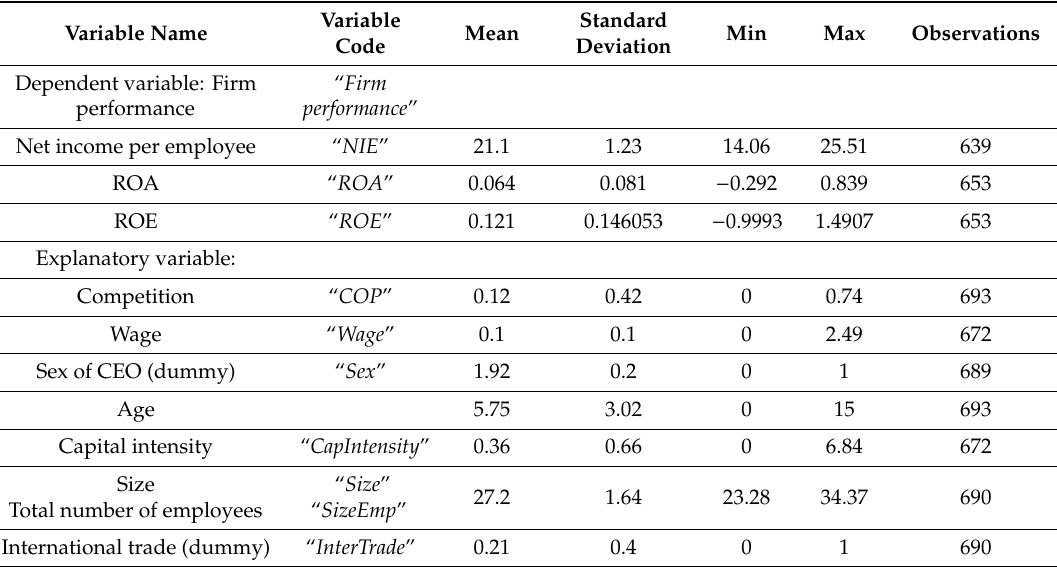
Table 1. Descriptive statistics of the